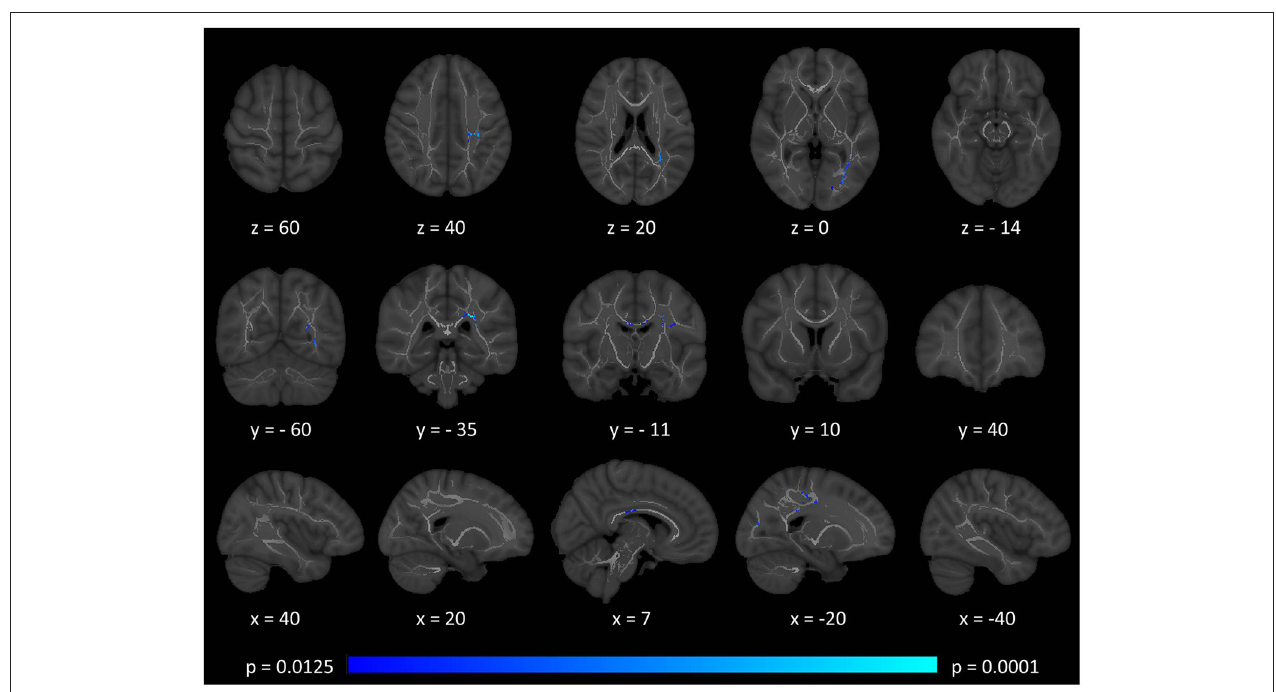
FIGURE 3 | Patterns of decreased fractional anisotropy (FA) in multiple sclerosis patients with gave-evoked nystagmus compared to healthy controls at p < 0.0125 FWE adjusted for age and gender following tract-based spatial statistics. Representative axial, coronal, and sagittal views are presented with corresponding MNI coordinates.